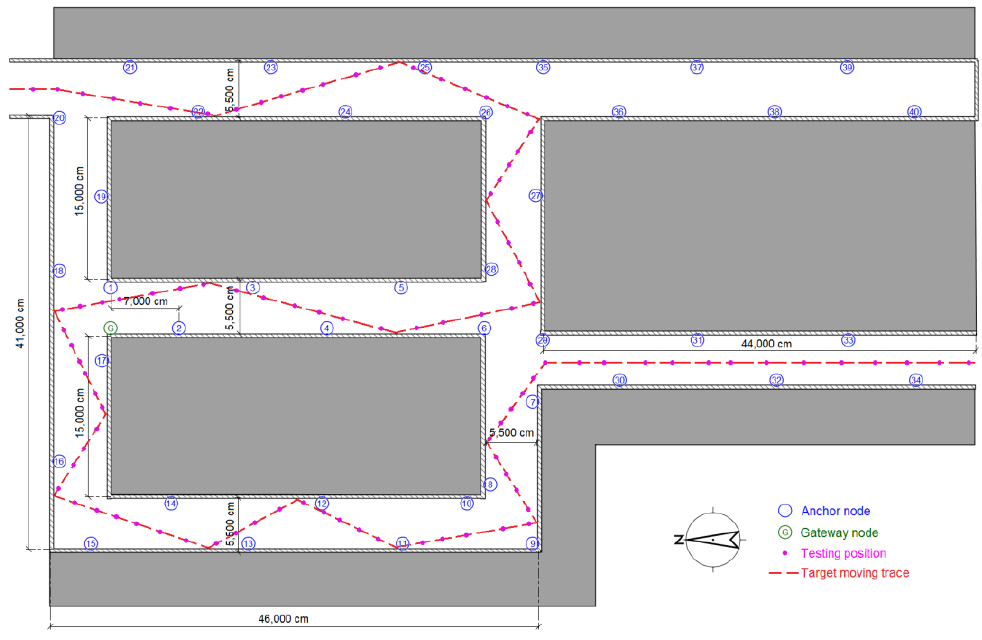
Figure 19. Map and nodes’ deployment for testing scenario 3.